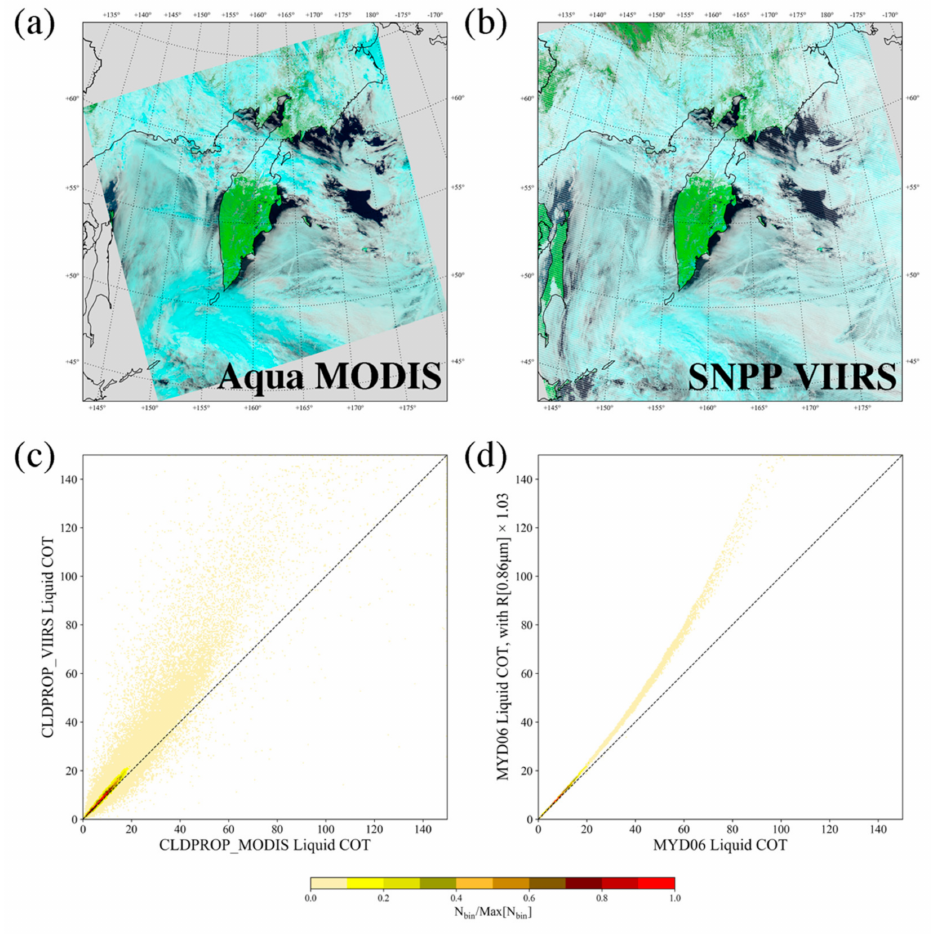
Figure 1. Coincident observations of the Kamchatka Peninsula from Aqua Moderate-resolution Imaging Spectroradiometer (MODIS) (0200 UTC granule) and Suomi National Polar-orbiting Partnership (SNPP) Visible Infrared Imaging Radiometer Suite (VIIRS) (0154 and 0200 UTC granules) on 6 July 2014. ( a ) MODIS false color RGB (MODIS B7-B2-B1). ( b ) VIIRS false color RGB (M11-M7-M5). ( c ) Density plot of co-located MODIS and VIIRS liquid phase cloud optical thickness (COT) retrievals (normalized by the maximum bin count) from an early cloud-top and optical properties (CLDPROP) development test for pixels over the ocean in this scene having intersensor view zenith and scattering angle di ff erences less than 1 ◦ . ( d ) Density plot of MYD06 liquid COT for the same pixel population, but with ordinate COT retrieved after increasing MODIS 0.86 µ m (B2) reflectance by 3%. The similarity between the two density plots implies that much of the VIIRS COT bias with respect to MODIS is due to a radiometric bias between the two sensors—i.e., VIIRS observes brighter reflectance than